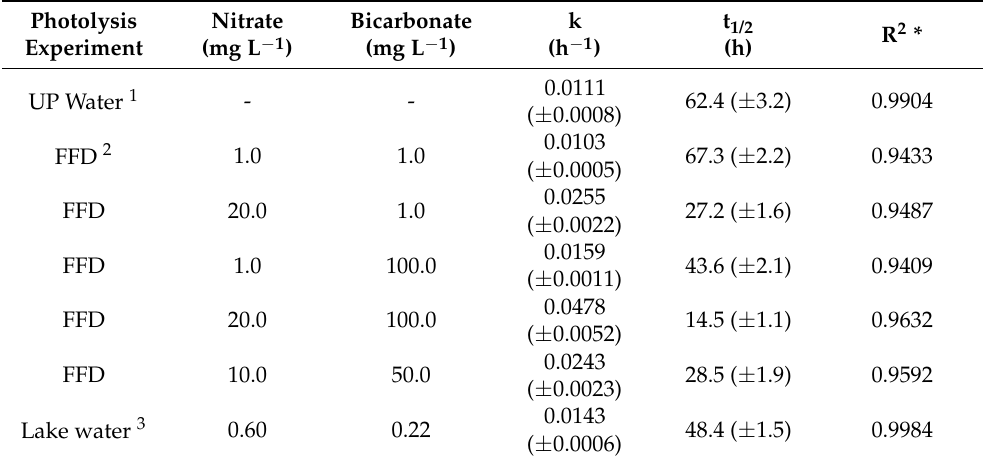
Table 1. Kinetics of escitalopram in different aqueous media conditions.